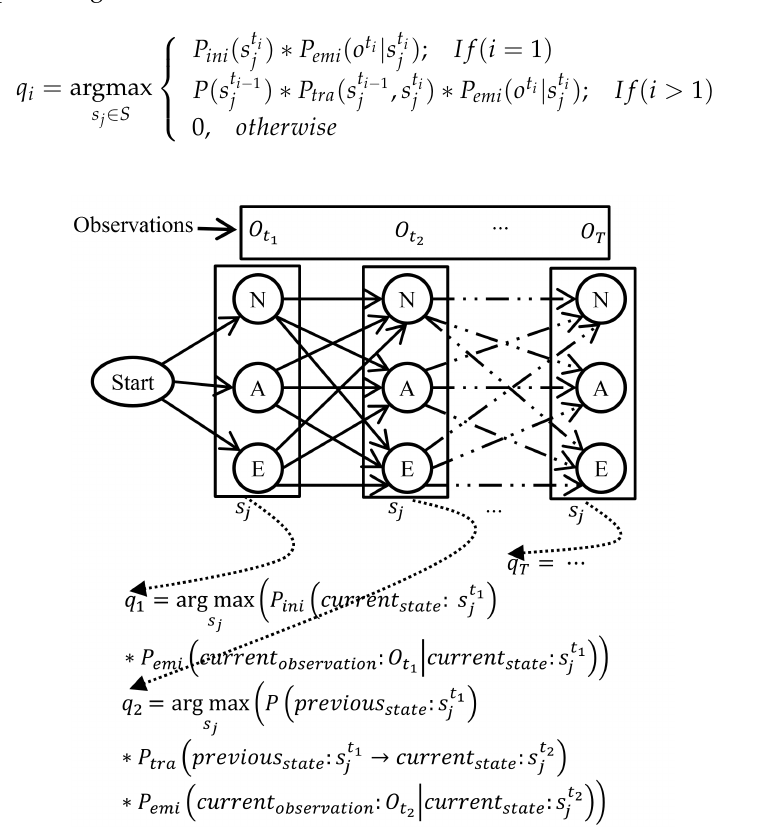
Figure 10. Trails of prediction of the psychiatric state from the observation of bio-signals and supporting features through the Viterbi algorithm